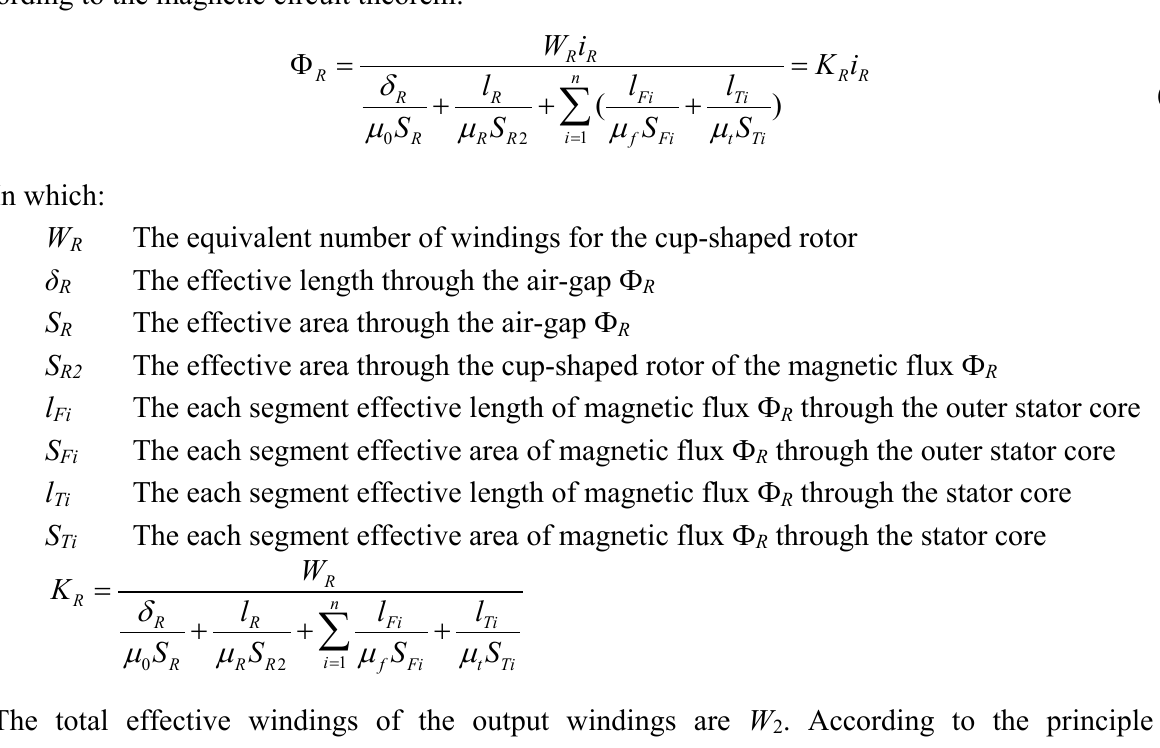
Figure 5. The magnetic circuit of Ф